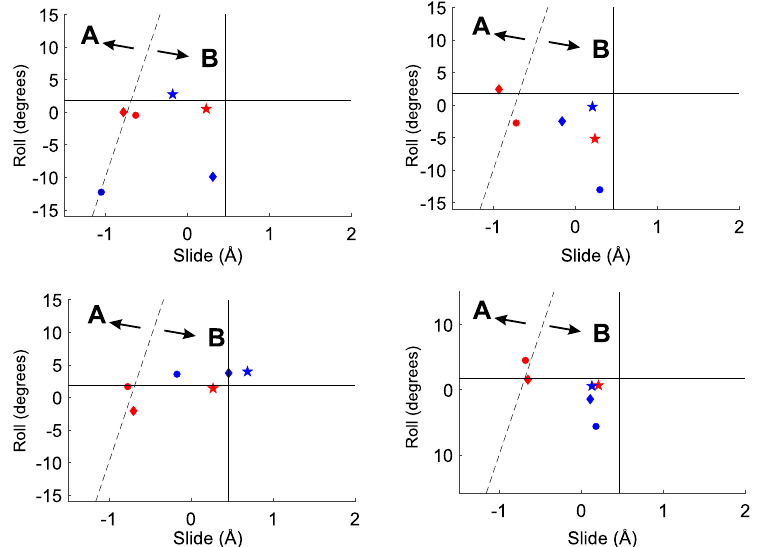
Figure 7. Predicted slide and roll coordinates of ss-C 4 . ( Top ): M06-2X; ( bottom ): B3LYP-D3. ( Left ): 6- 31G(d,p); ( right ): TZVP. Blue: mechanical embedding; red: electrical embedding. • : 5 (cid:48) -C ( 1 ) /C ( 2 ) steps; (cid:7) C ( 2 ) /C ( 3 ) steps; and (cid:70) : C ( 3 ) /C ( 4 ) -3 (cid:48) steps. The average slide and roll coordinates of the starting calf-thymus B-DNA conformation are reported as full lines. The dashed line separates the A- and B-DNA forms